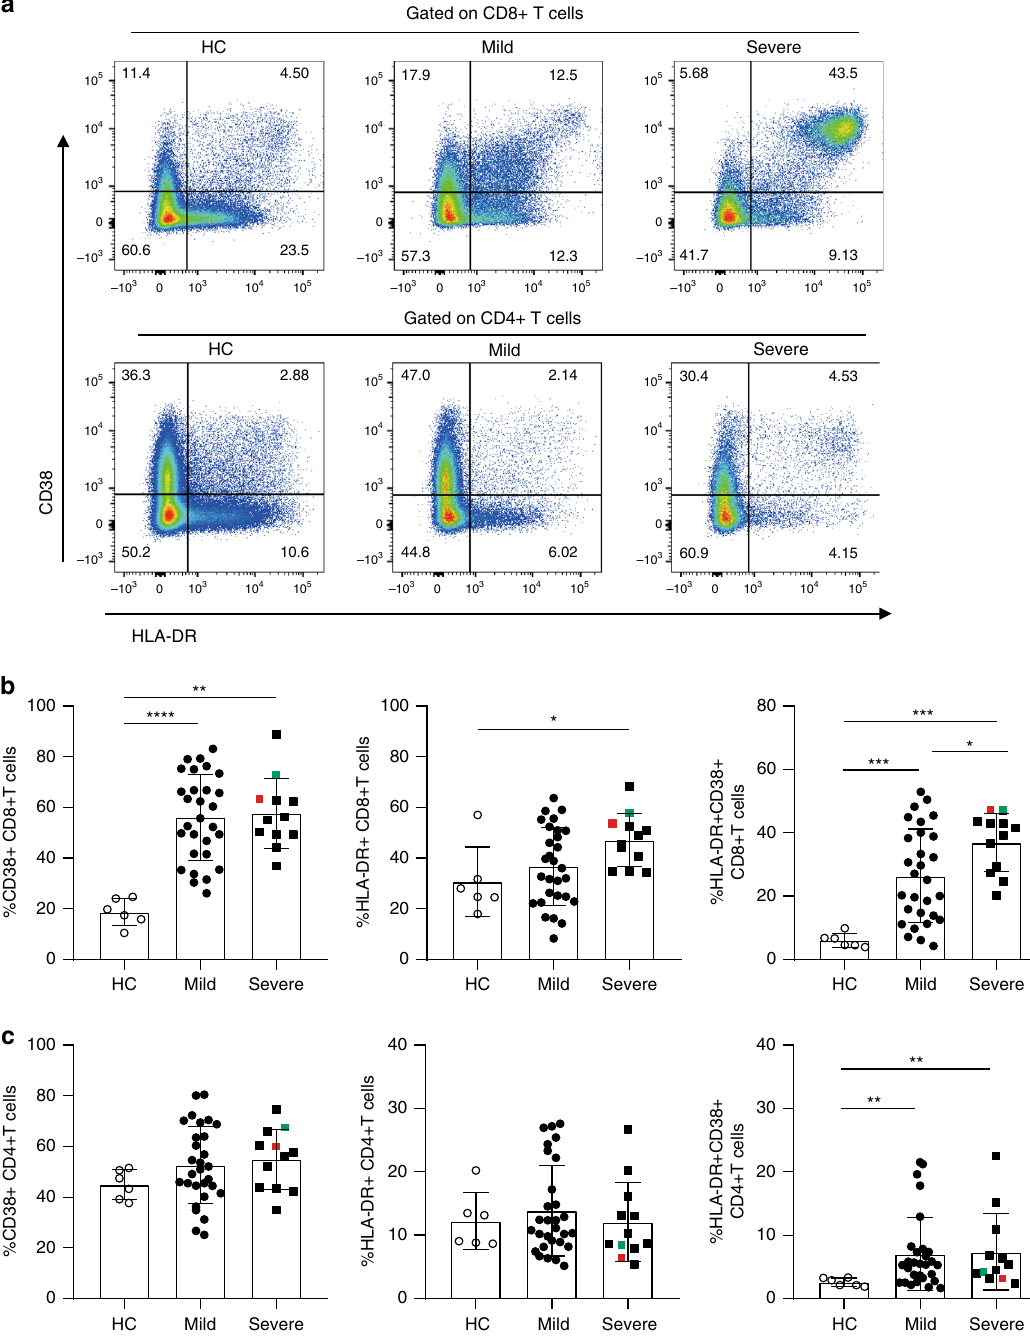
Fig. 2 Increased expression of activation markers on T cells in SARS-CoV-2 infected patients. a Representative dot plots showing CD38 and HLA-DR expression on CD8 + and CD4 + T cells from PBMCs of HC, Mild and Severe COVID-19 patients. b , c The percentage of CD38 and HLA-DR single positive or double positive b CD8 + T cells or c CD4 + T cells in PBMCs of HC ( n = 6), mild (n = 29) and severe ( n = 12) SARS-COV-2 infected patients was assessed by fl ow cytometry. Colored symbols indicated deceased cases. Data are expressed as mean ± SD. * p < 0.05, *** p < 0.001, **** p < 0.0001, by two- tailed Mann – Whitney U -test for b ( p < 0.0001 and p = 0.0001 for CD38 + CD8 + T cells, p = 0.0135 for HLA-DR + CD8 + T cells, and p = 0.0002, p = 0.0001, and p = 0.0372 for HLA-DR + CD38 + CD8 + T cells) and c ( p = 0.0088 and p = 0.0046 for HLA-DR + CD38 + CD4 + T cells, respectively). Source data included as a Source Data